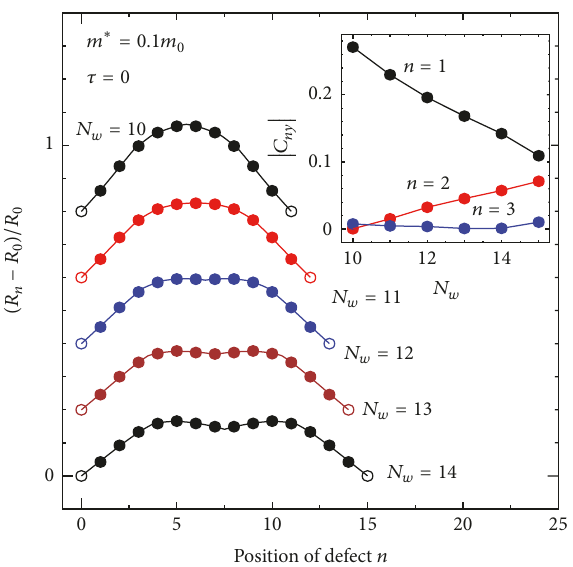
Figure 6: Change in resistance (𝑅 𝑛 − 𝑅 0 )/𝑅 0 for 𝑚 ∗ = 0.2𝑚 0 .